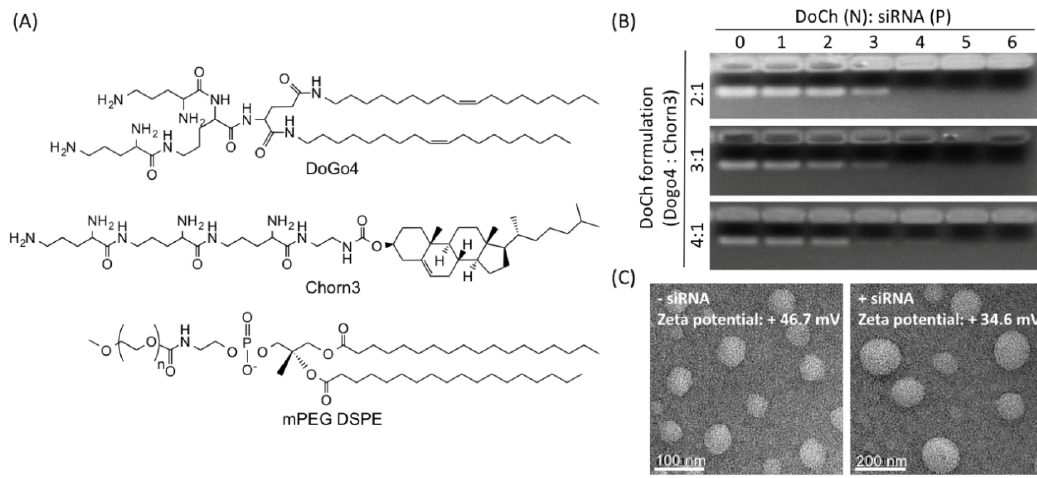
Figure 1. Formulation and characterization of DoCh LNP. ( A ) Composition of DoCh LNP formulation; ( B ) Agarose gel image showing siRNA binding affinity of DoCh LNP formulations; ( C ) TEM images of DoCh LNP before and after binding with siRNA. Table 2. Particle size and zeta potential of DoCh formulations before and after siRNA loading.